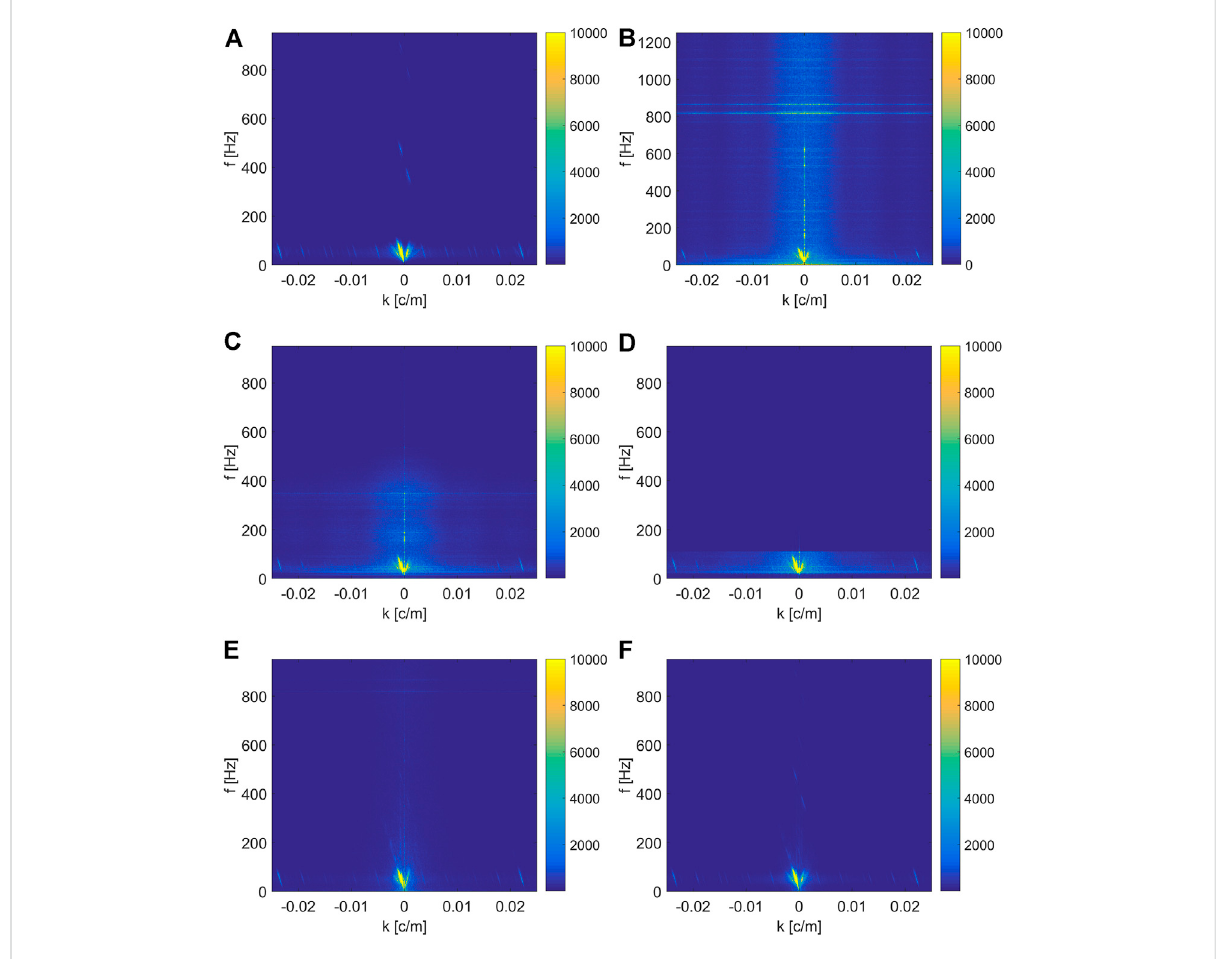
FIGURE 8 F-k spectra comparisons of denoised results. (A) F-k spectrum of Figure 5A, (B) f-k spectrum of Figure 5C, (C – F) f-k spectra of denoised results in Figure